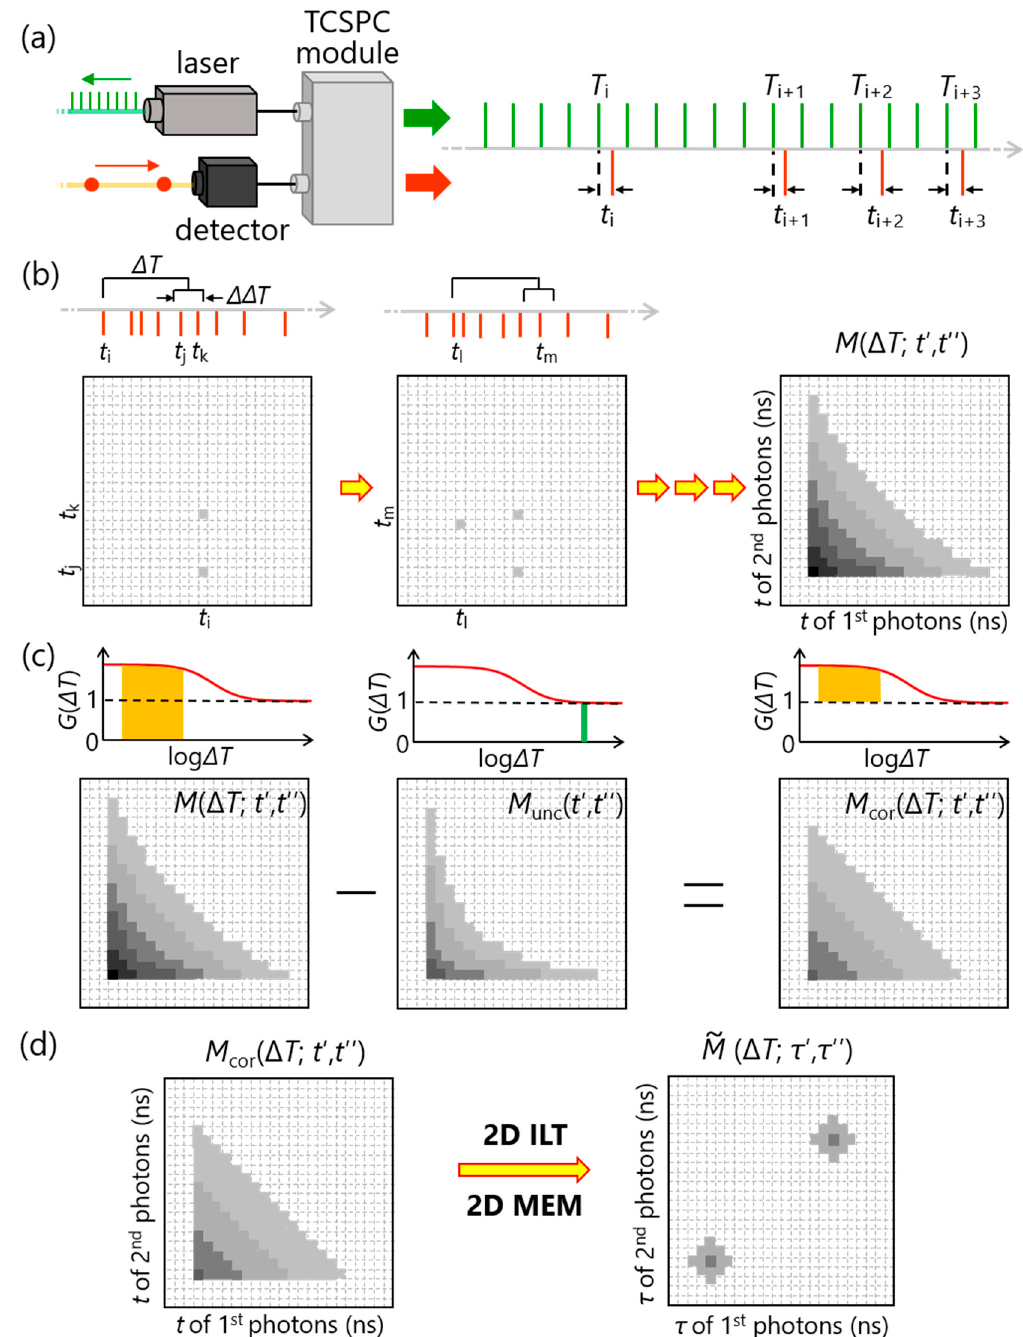
Figure 2. Schematic of 2D FLCS analysis. ( a ) Accumulation of photon data. For each detected photon, macrotime ( T ) and microtime ( t ) are stored as photon data. ( b ) Construction of a 2D emission-delay correlation map. ( c ) Subtraction of uncorrelated photon pairs. ( d ) Conversion from the 2D emission-delay correlation map to a 2D lifetime correlation map by 2D inverse Laplace transform (ILT) with the help of 2D maximum entropy method (2D MEM).